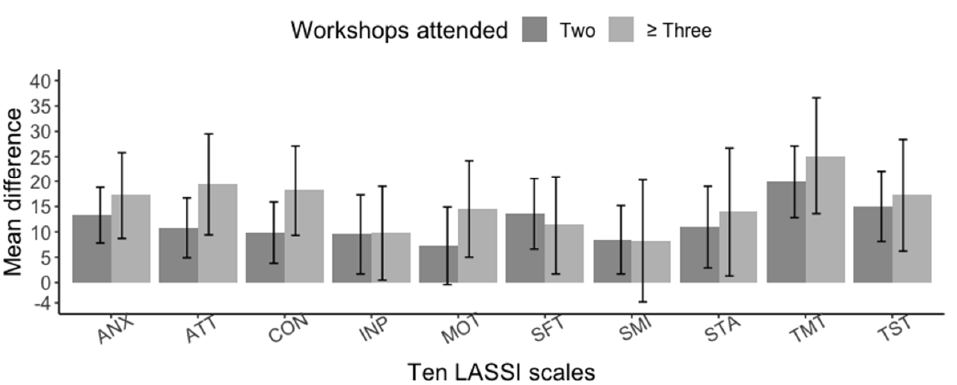
Figure 3. Sensitivity analysis of pre- and post-LASSI test scores by the number of workshops attended during the USFQ’s Keys to Academic Success Program. Abbreviations: ANX, Anxiety; ATT, Attitude; CON, Concentration; INP, Information Processing; MOT, Motivation; SFT, Self-Testing; SMI, Selecting Main Ideas; STA, Study Aids; TMT, Time Management; TST, Test Strategies. Furthermore, a higher percentage improvement was evident in the students who at- tended three or more workshops compared to only two (Supplementary Materials: Table S3). It is worth mentioning that students with the lowest pre-LASSI scores overall